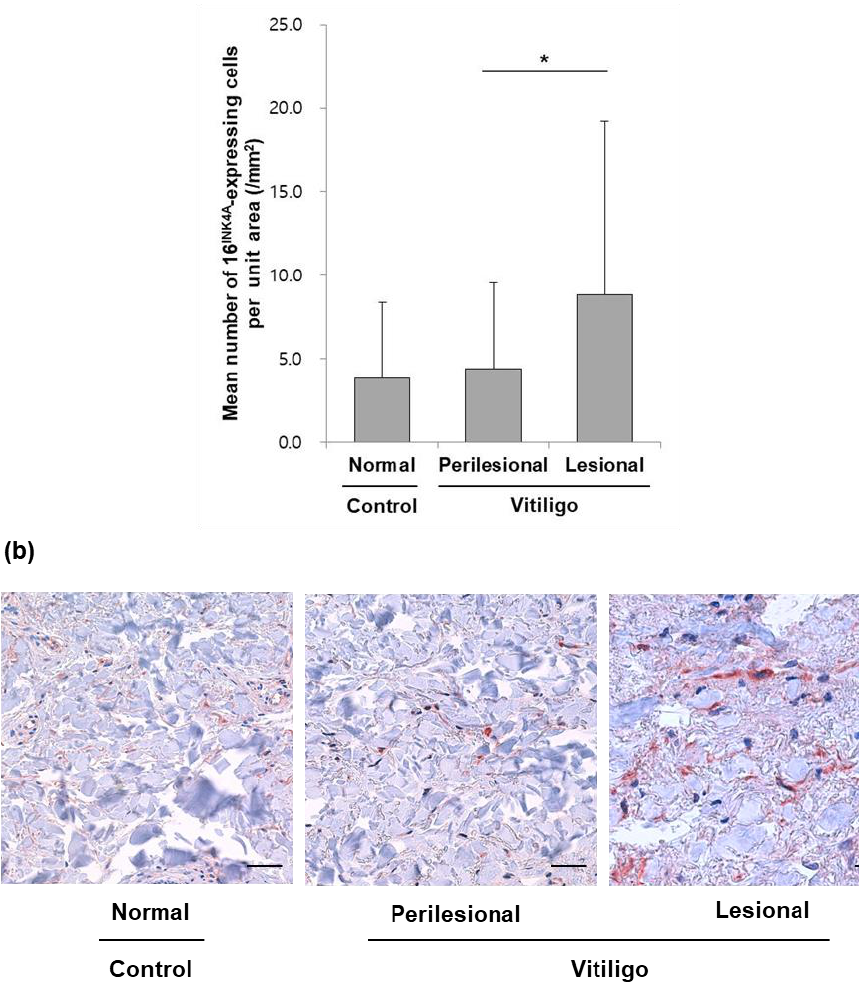
Figure 2. Number of p16 INK4A -positive cells in the dermis: ( a ) p16 INK4A positive cells were quantified according to the measured dermal area (/mm 2 ) of each skin specimen. These results are shown in the form of a comparison between all NSV patients and the normal controls. Data are presented as the mean ± SE, n = 54 patients with NSV, n = 33 normal controls; * p = 0.0035 from paired Student’s t -tests. ( b ) Senescence marker, p16 INK4A , and expression levels from vitiligo tissue biopsies. The number of p16 INK4A positive cells was more significantly increased in the dermis of the lesional skin from NSV patients compared to perilesional skin or normal control skin samples (scale bar, 100 μm).